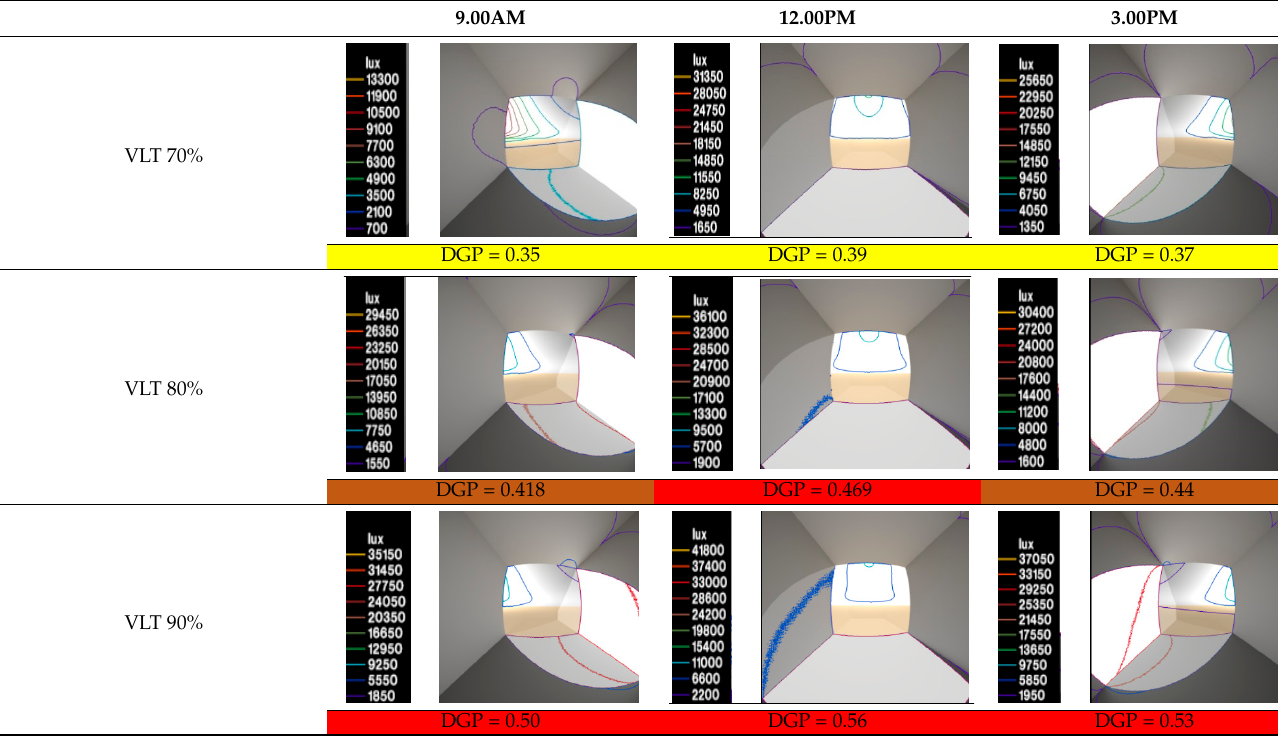
Table 5. The Daylight glare probability analysis with illuminance contour map at summer solstice 21 June 2020 (9am, 12pm, and 3pm).